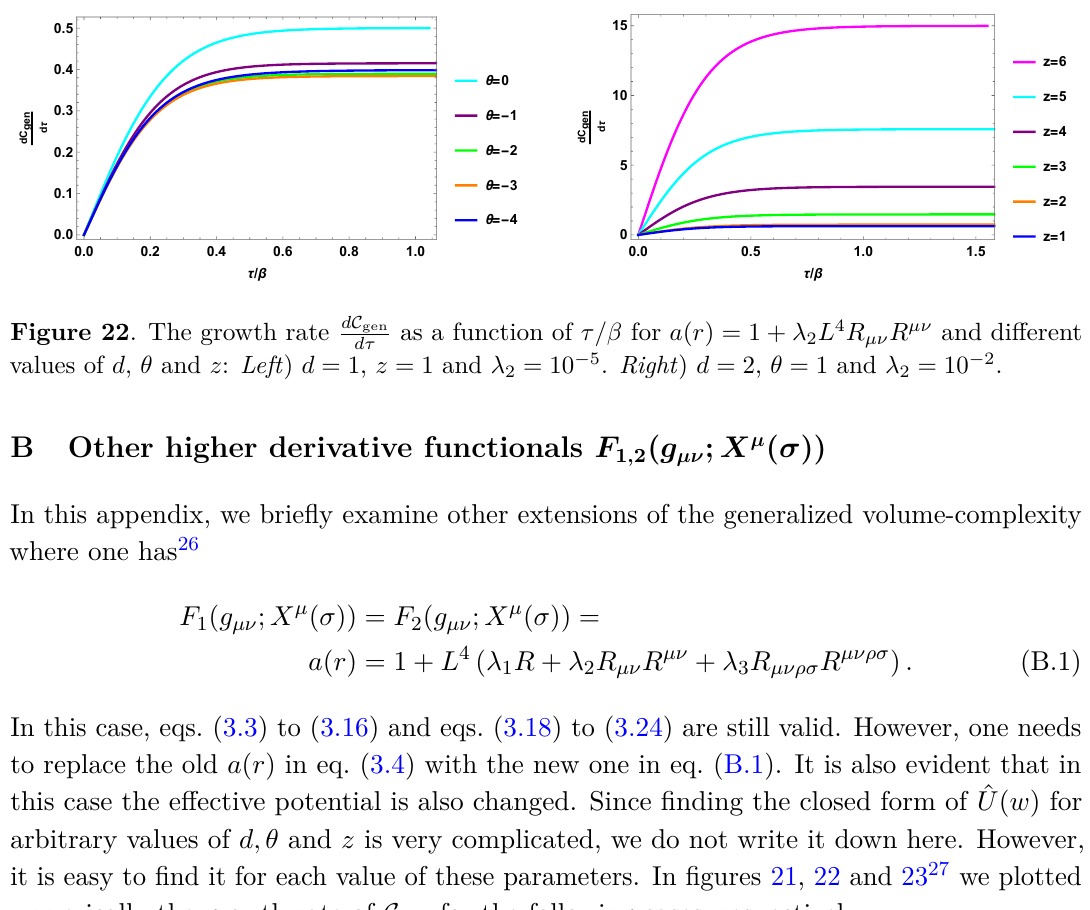
Figure 21 . The growth rate d C gen of d , θ and z : Left ) d = 1 , z = 1 and λ